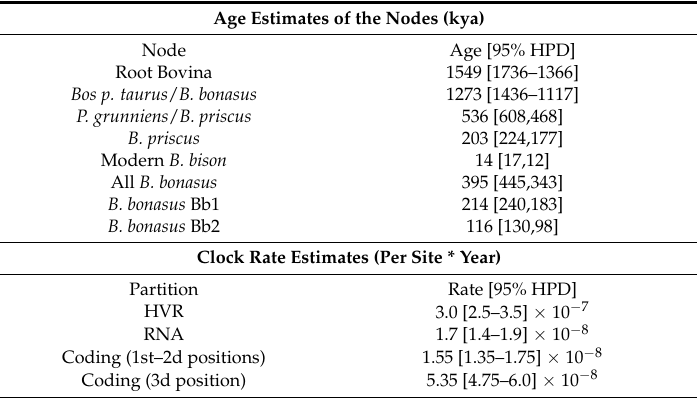
Table 1. Node age estimates and clock rates estimates obtained through Bayesian